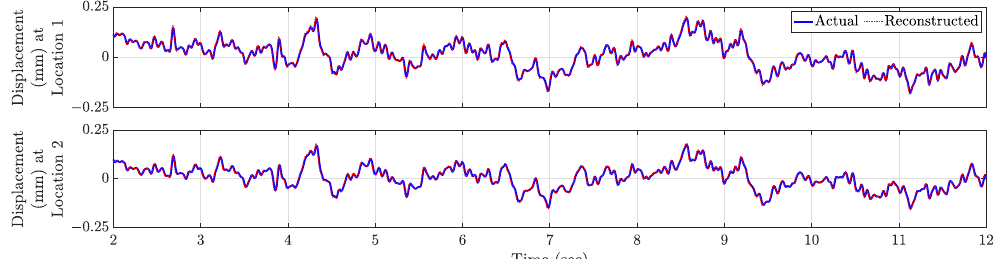
Figure 10. Comparison of actual and reconstructed time history response at Locations 1 (‘cyan diamond’) and 2 (‘magenta star’) in Figure 9c.